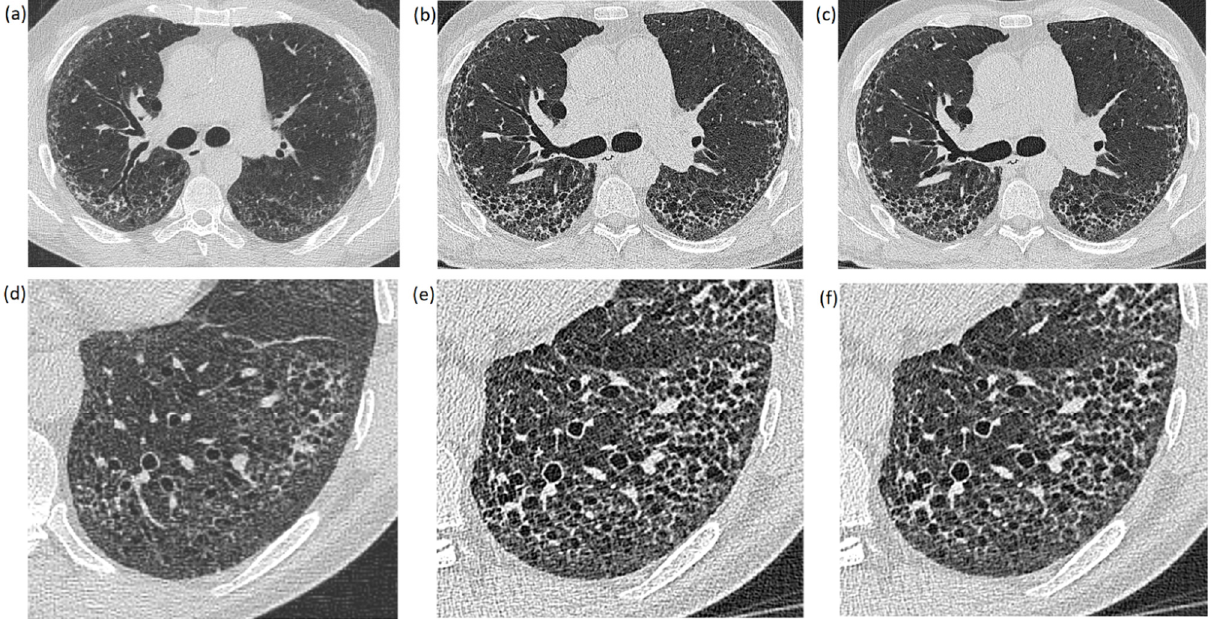
Figure 1. Images of the whole lung ( a – c ) and enlarged image sections ( d – f ) of the same patient: ( a , d ) were created with the EID-CT scanner; ( b , e ) were created with a PCCT scanner without an iterative reconstruction algorithm (QIR − ); and ( c , f ) are PCCT images reconstructed with an iterative reconstruction algorithm (QIR+).